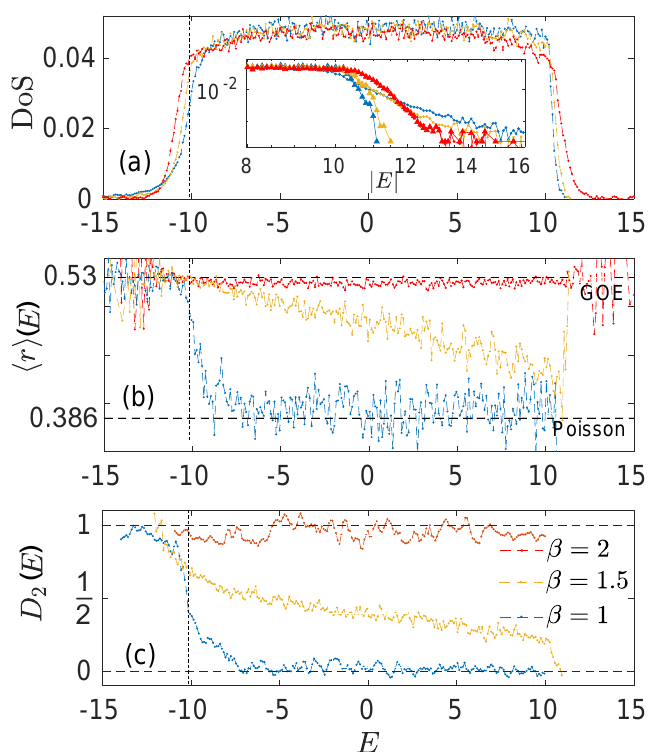
Figure 2: Emergence of the finite-size mobility edge across the Anderson tran- sition. (a) global density of states (DOS), (b) energy-resolved level-spacing ratio r -statistics 〈 r 〉 ( E ) , and (c) energy-resolved fractal dimensions D for each eigenstate 2 versus energy E in the localized ( a = 1.5, β = 1, blue), critical ( a = β = 1.5, yellow), and delocalized ( a = 1.5, β = 2, red) phases. Both panels (b) and (c) show localized (blue), critical (yellow) and ergodic (red) eigenstate properties in the spectral bulk. The bulk states are within the range [ − W / 2, W / 2 ] , where we take W = 20. The inset to panel (a) shows power-law tails of DOS at either ( a > a ) or both ( a < a ) AT AT spectral edges beyond the bulk, which correspond to the ergodic states in panels (b) and (c). For the energy-resolved data the bins of the 50 adjacent states are used. The data for D are extrapolated from L = 100, 150, 200, and 250 with the corre- 2 sponding number of disorder realizations 1000, 500, 100, and 50, respectively, see Sec. 4.2.1 for details. For the rest of the data L = 250. The vertical dashed lines pro- vide the position of the finite-size mobility edge extracted from the finite-size data for r